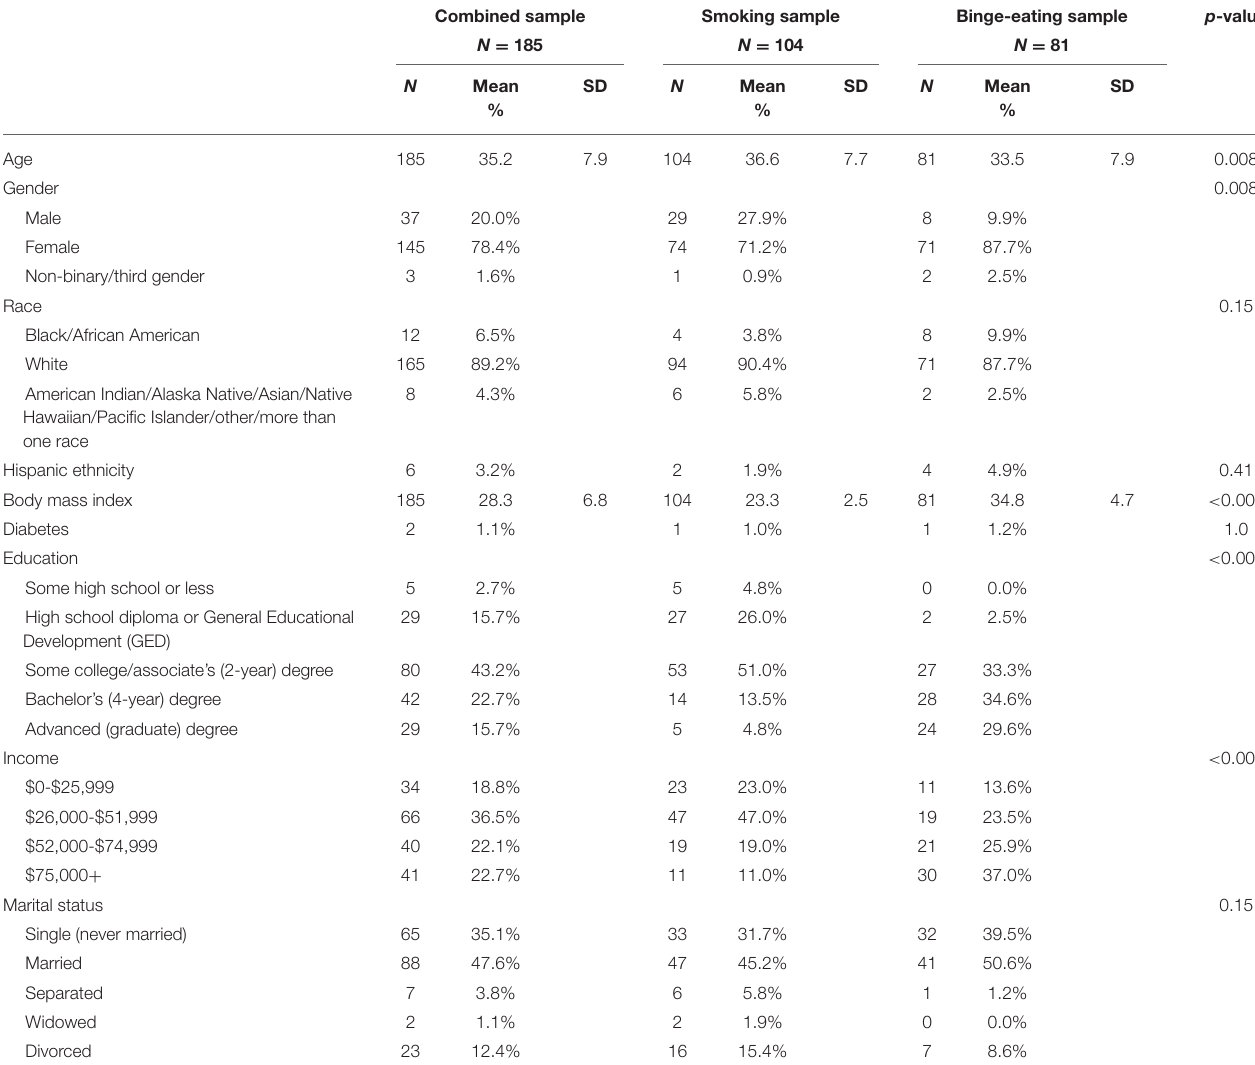
TABLE 1 | Participant demographics in the combined, smoking, and binge-eating samples. Combined sample Smoking